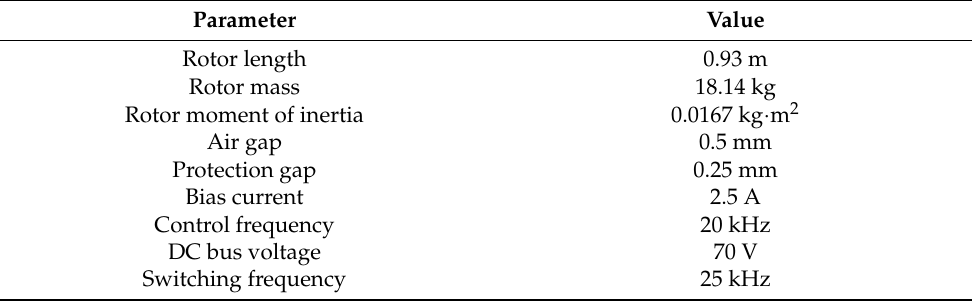
Table 1. Parameters of the experimental platform.